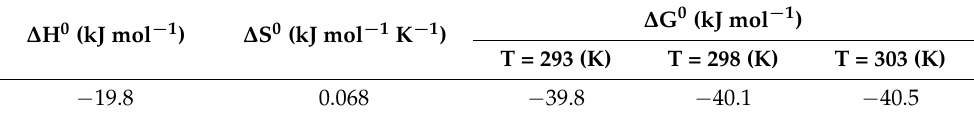
Figure 10. van’t Hoff plot for the adsorption of Sb (III) onto ox-xGnP. Table 4. Thermodynamic parameters of Sb (III) adsorption on ox-xGnP. ∆ H 0 : enthalpy, ∆ S 0 : entropy, ∆ G 0 : Gibb’s free